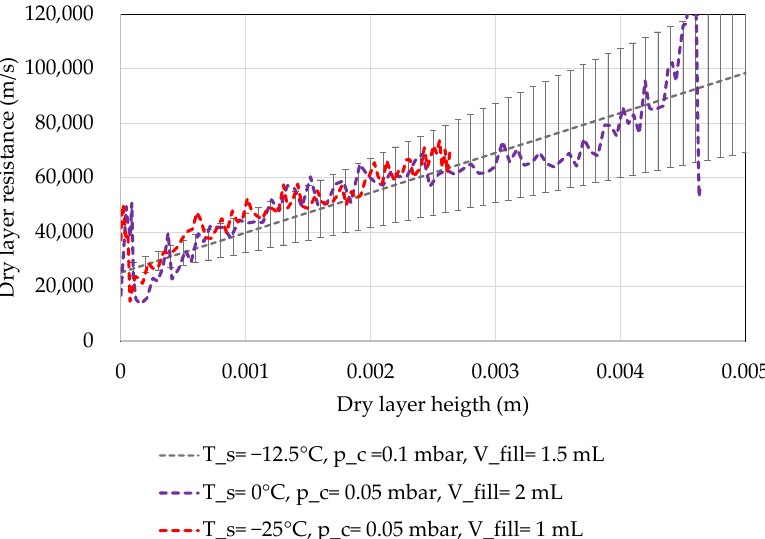
Figure 10. Experimentally determined R p values with varying process conditions for 25 g/L saccharose.